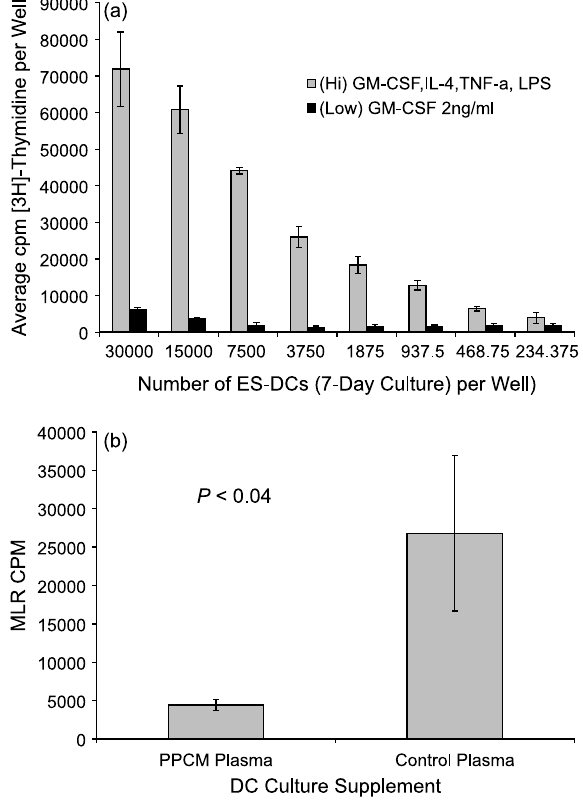
Figure 1. (a) Human cord blood derived dendritic cells induce allo-proliferation of PBMCs. Cord blood derived CD34 þ cells were cultured in serum-free stem cell media supplemented with low dose (2ng/ml) GM-CSF (Low) alone to promote development of immature progenitor DC or with high dose GM-CSF (10ng/ml) plus IL-4 (10ng/ml), TNF- a (10ng/ml) and LPS (1 m g/ml) (Hi) to promote development of mature DC. Cell (allo-) proliferation assays (MLR) were conducted for 96h with two sets of